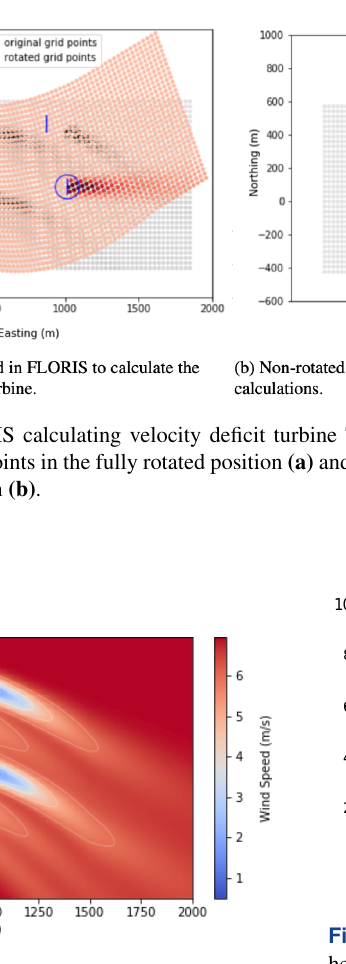
Figure 8. Visualization of a flow field with heterogeneous wind direction. Turbine rotors are indicated by black lines.